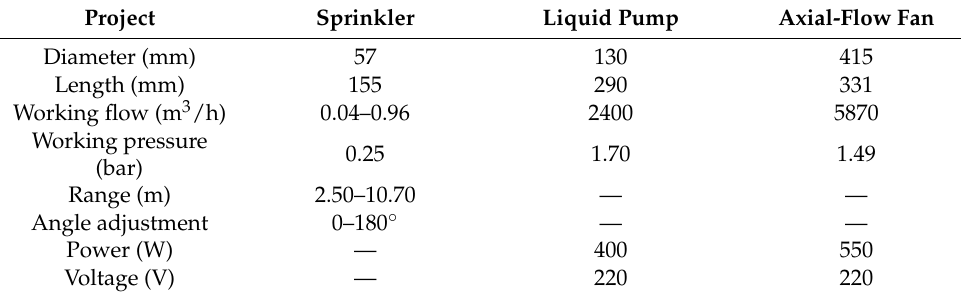
Table 2. The parameters of main experimental equipment. Project Sprinkler Liquid Pump Axial-Flow